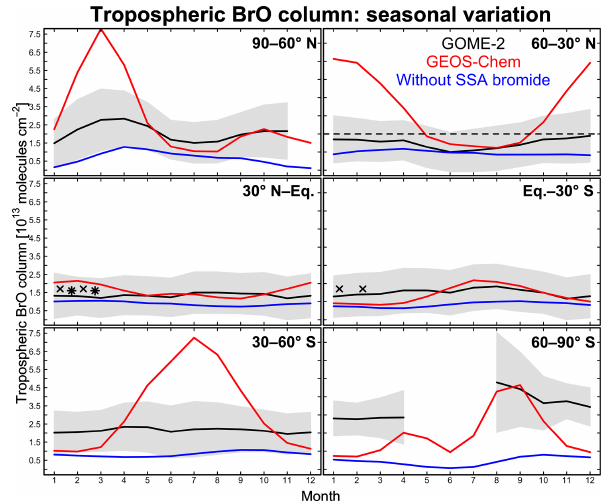
Figure 4. Seasonal variation of zonal mean tropospheric BrO columns in different latitudinal bands. Monthly GOME-2 BrO ob- servations are for 2007 and taken from Theys et al. (2011); shading represents 1 standard deviation about the monthly mean GOME- 2 BrO columns. GEOS-Chem BrO columns are sampled at the GOME-2 local overpass time (09:00–10:00). Red lines are from our standard simulation including sea salt aerosol (SSA) debromi- nation; blue lines are from a sensitivity simulation without SSA debromination. The dashed black line indicates observations for 2009–2011 reported by Coburn et al. (2011) in Florida, USA, with- out seasonality information. Black crosses and stars represent av- erage BrO columns measured during aircraft campaigns over the eastern tropical Pacific (Volkamer et al., 2015; Wang et al., 2015; Dix et al., 2016) and western tropical Pacific (Koenig et al., 2017),